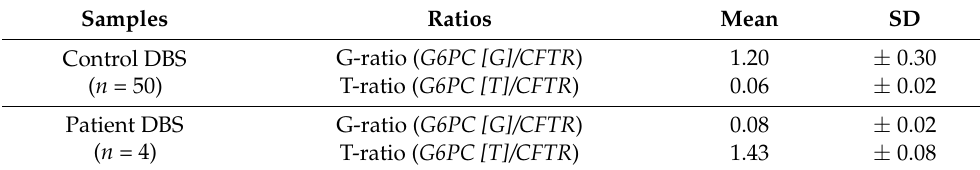
Table 1. Mean values of the peak height